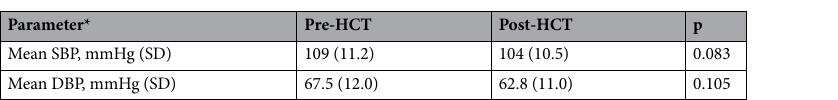
Table 3. Mean office SBP and DBP values in the pre-HCT group compared with the post-HCT group. *n of measurements 56.